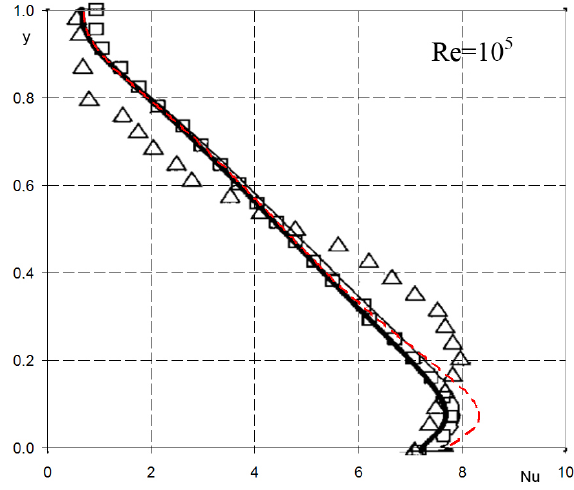
Figure 6: The local Nusselt number at Re = 10 5 ( •• [2], △△ [3], [4], −− CVM).